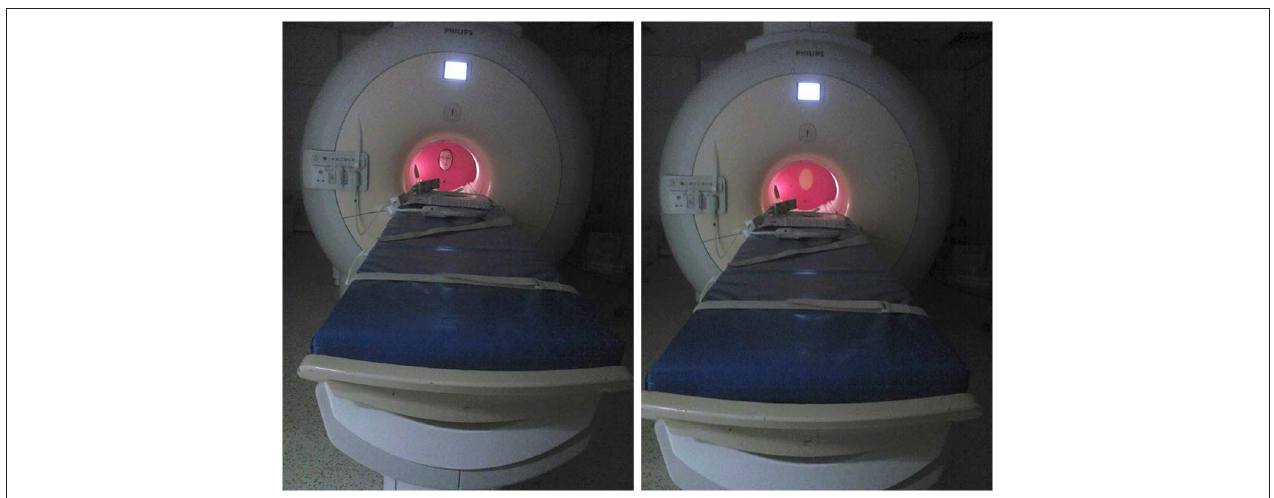
FIGURE 2 | In-scanner setup of the equipment and stimulus presentation. The individual shown on the figure is an author of this paper and consented to the publication of their